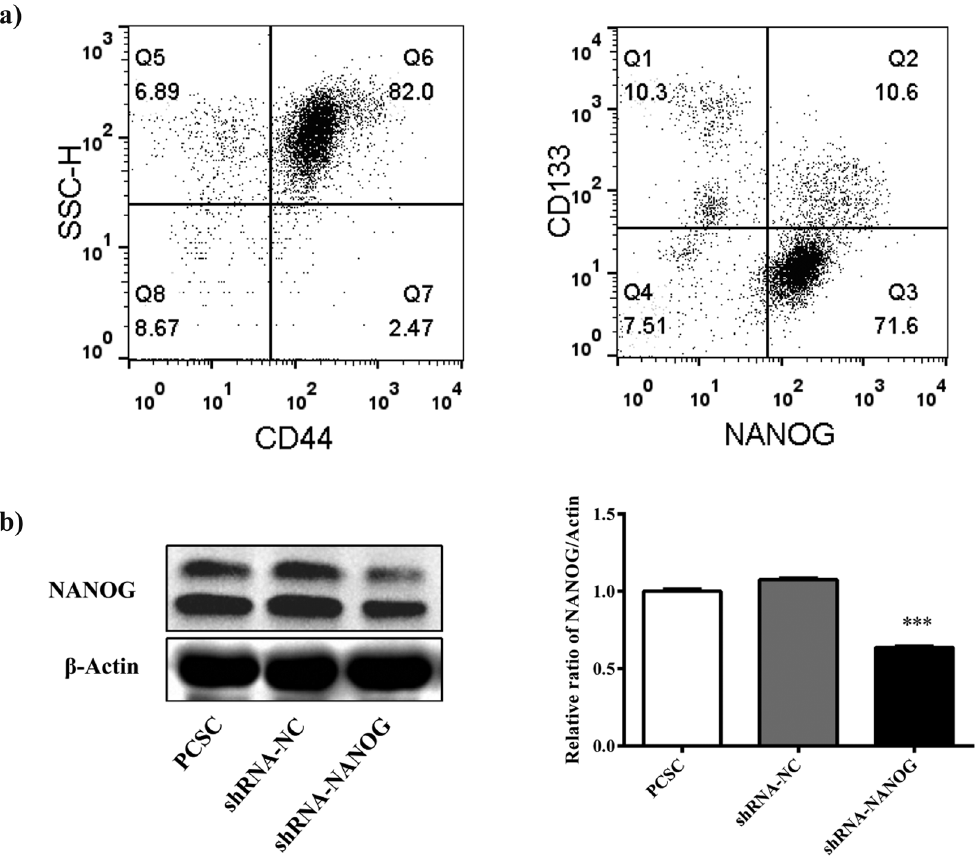
Figure 1: shRNA downregulates the expression of NANOG in PCSCs. Screening for CD44/CD133/NANOG - positive PCSC by fl ow cytometry ( a ) . Western blot was used to detect the level of protein expression of NANOG ( b ) . After the transfection of sh - NANOG, the expression of NANOG was signi fi cantly downregulated ( * p < 0.05, ** p < 0.01, and *** p < 0.001 )